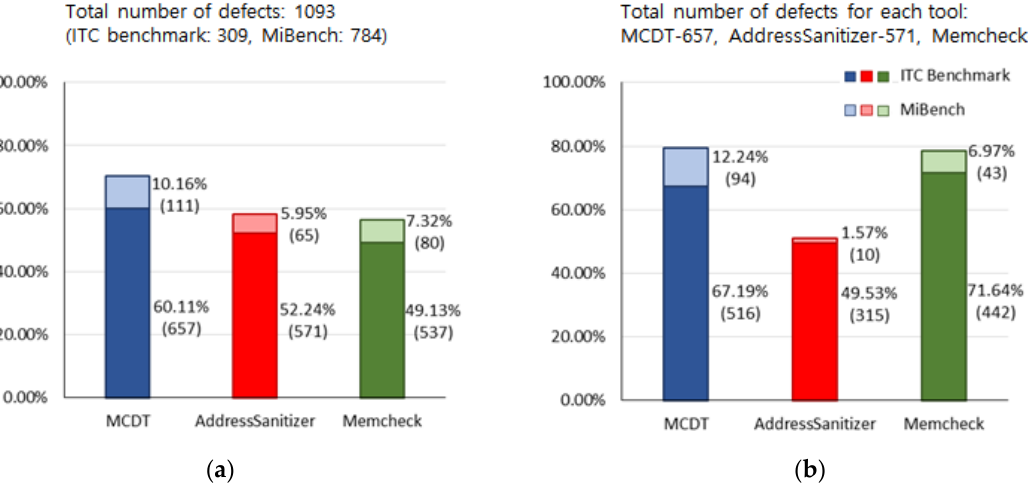
Figure 12. Effectiveness of memory defect-detection; ( a ) defect-detection rate; ( b ) defect-cause accuracy.